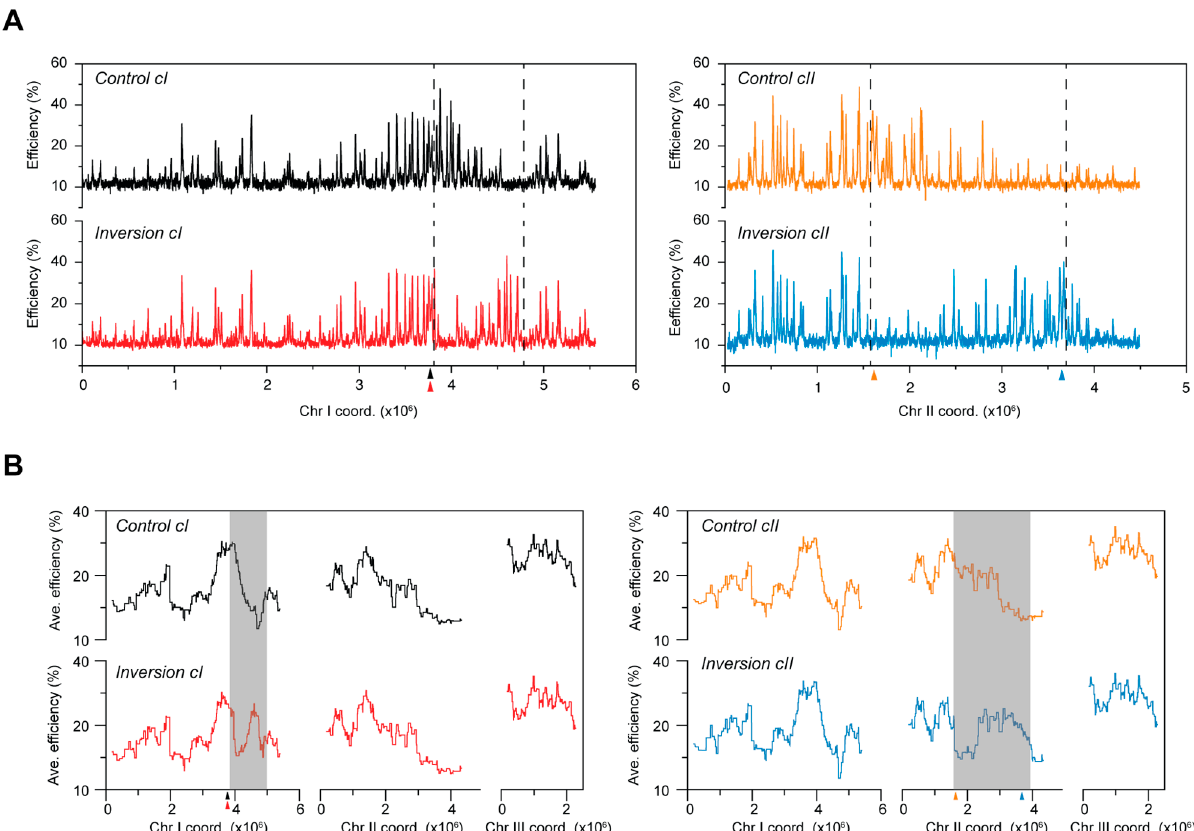
Figure 2. Alterations in replication domains resulting from chromosomal inversions. ( A ) Replication profiles of the chromosomal inversions plotted using the actual post-rearrangement chromosomal coordinates. Only the chromosomes harboring the inversions are shown. Black: Control cI , red: Inversion cI , orange: Control cII , blue: Inversion cII. x -axis: chromosome coordinates, y -axis: origin efficiencies. ( B ) Profiles of replication domains. Averages of origin efficiencies were determined for continuous windows of ~250 kb (1000 probes) across the entire genome. x -axis: chromosome coordinates, y -axis: average origin efficiencies. Gray boxes highlight changes in origin efficiency domains along the chromosomes that result from chromosomal inversions. Triangles with colors corresponding with each of the strains indicate the positions of